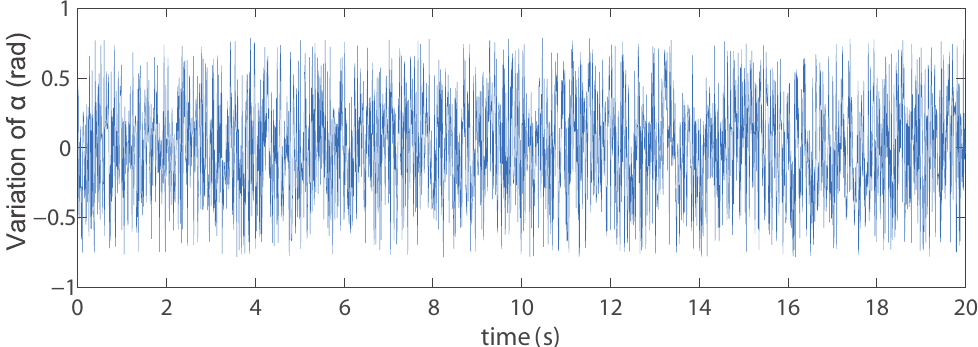
Figure 15. Variation of the image moment α for the Triangle